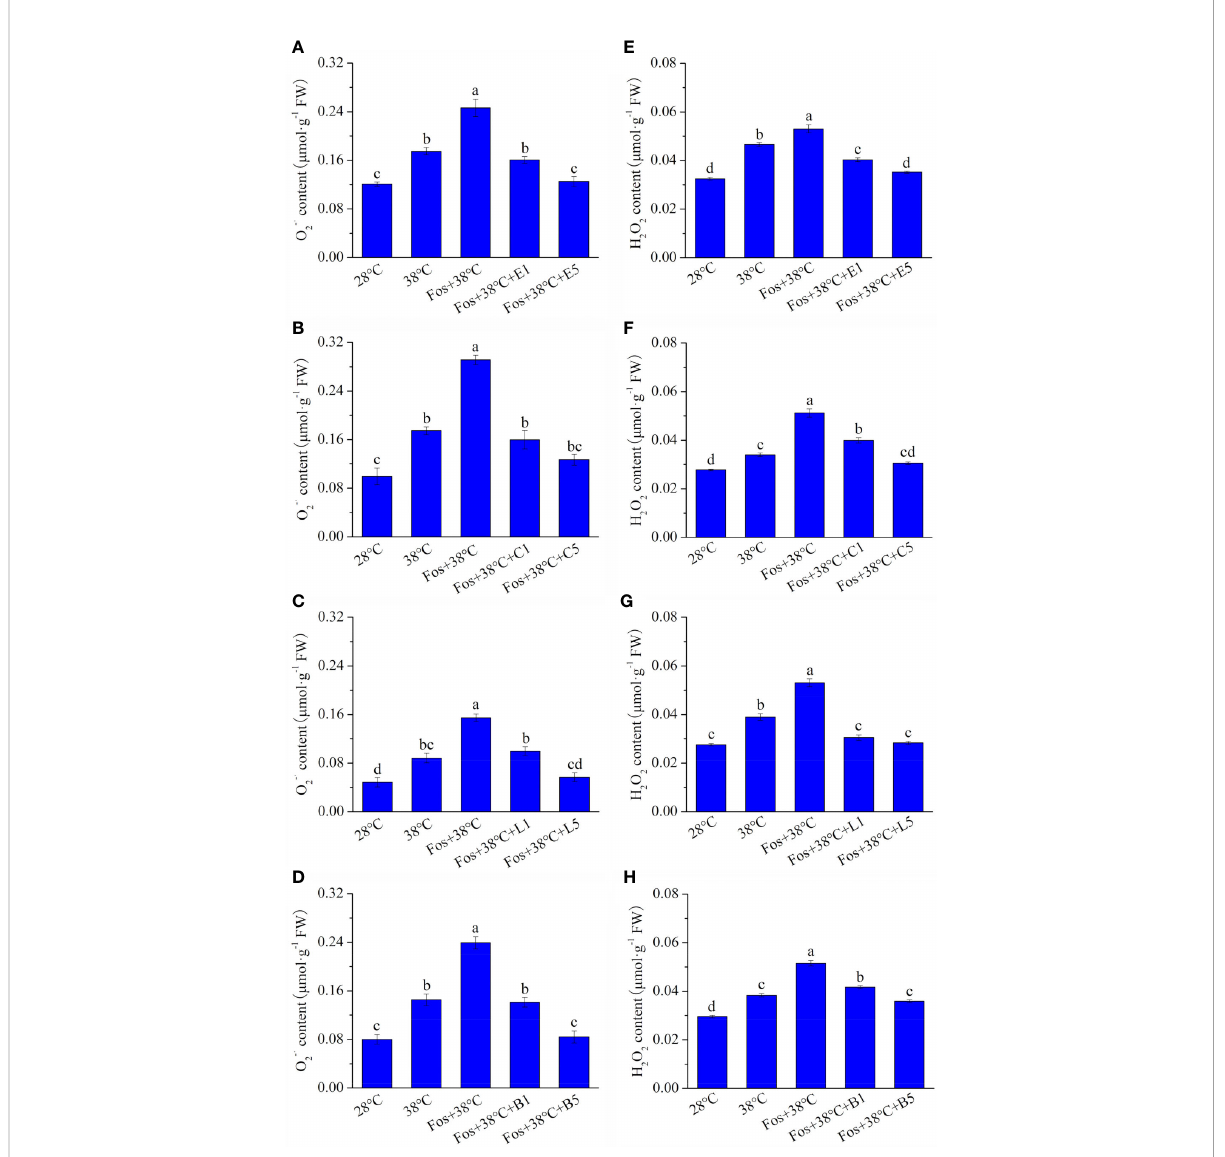
FIGURE 1 Effects of the uppermost monoterpenes on O 2 – · (A – D) and H 2 O 2 (E – H) levels in C. camphora . (A, E) Eucalyptol chemotype (EuL); (B, F) Camphor chemotype (CmR); (C, G) Linalool chemotype (LnL); (D, F) Borneol chemotype (BeL). 28°C, 38°C, and Fos+38°C: C. camphora was treated with normal temperature, high temperature, and high temperature with fosmidomycin (Fos) pretreatment, respectively. Fos+38°C+E1 and Fos+38°C+E5: EuL blocked monoterpene synthesis with Fos was fumigated with 1 and 5 m M eucalyptol at 38°C, respectively. Fos+38°C+C1 and Fos+38°C+C5: CmR blocked monoterpene synthesis with Fos was fumigated with 1 and 5 m M camphor at 38°C, respectively. Fos+38°C+L1 and Fos+38°C+L5: LnL blocked monoterpene synthesis with Fos was fumigated with 1 and 5 m M linalool at 38°C, respectively. Fos+38°C+B1 and Fos+38°C+B5: BeL blocked monoterpene synthesis with Fos was fumigated with 1 and 5 m M borneol at 38°C, respectively. Different lowercase letters indicate the signi fi cant difference at P < 0.05. Means ± SE (n =